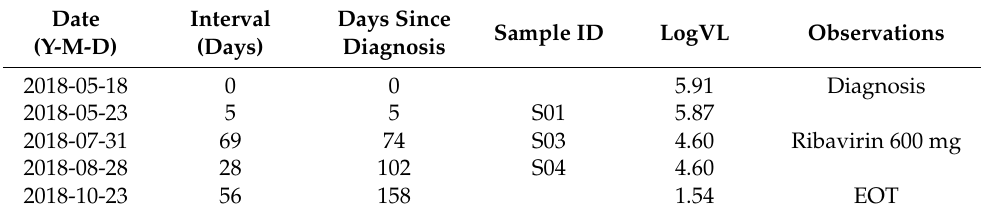
Table 2. Follow-up data, with dates and intervals, viral loads expressed as logarithms, and clinical observations. EOT, end of